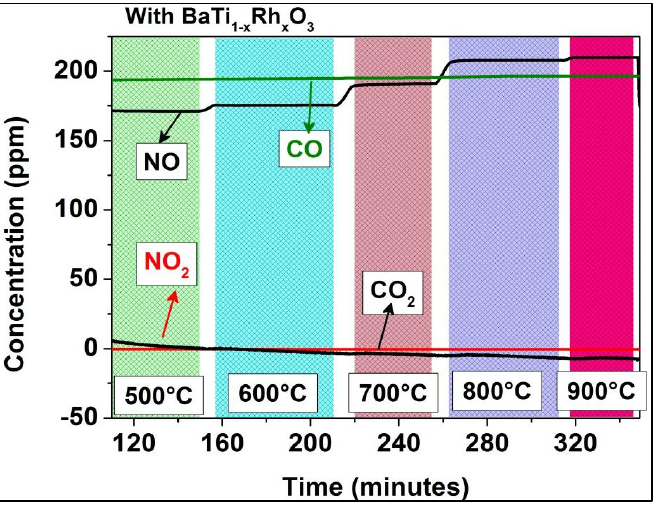
Figure 12. Temperature-dependent conversion of NO 2 and CO with BaTi 0.95 Rh 0.05 O 3 catalytic powder present in the test chamber.